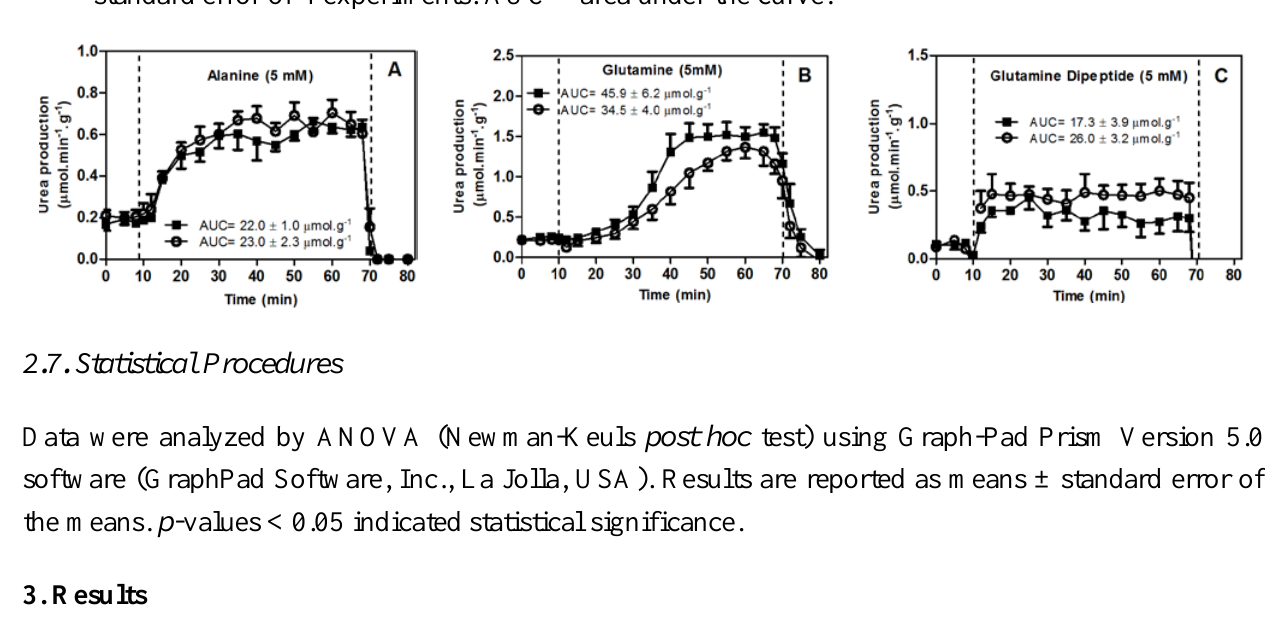
Figure 2. Urea production from alanine ( A ); glutamine ( B ); and glutamine dipeptide ( C ) in livers from rats fasted for 15 h. Livers were perfused as described in the experimental section. Experiments were performed 30 min after intraperitoneal administration of saline (Control group, ■) or insulin detemir (Hypoglycemic group, ○ ). Data are expressed as means ± standard error of 4 experiments. AUC = area under the